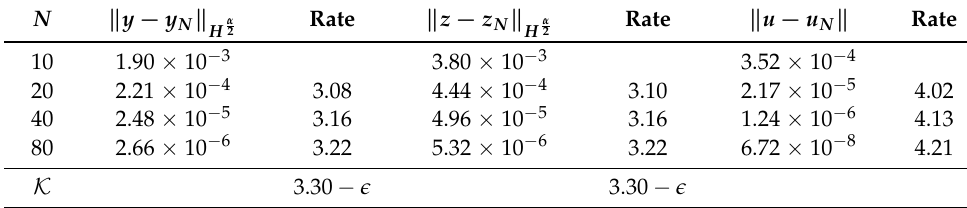
Table 6. Errors and convergence rate of y , z , u in non-weighted Sobolev norm with α =